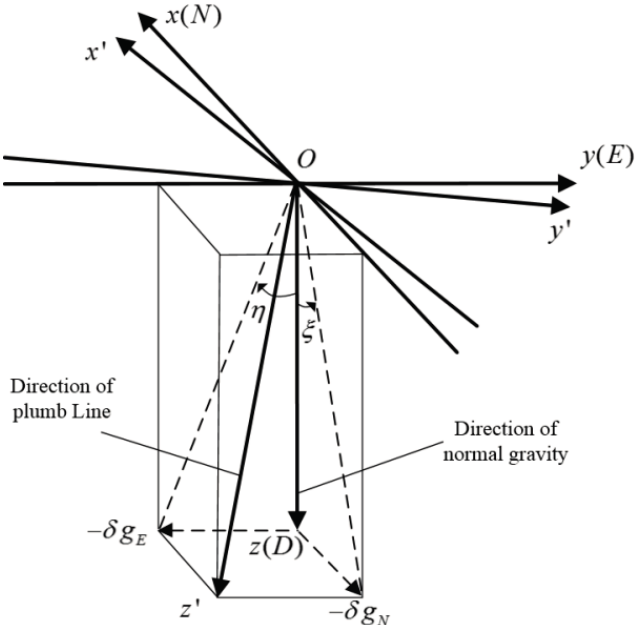
Figure 1. The definition of coordinates and deflections of the vertical